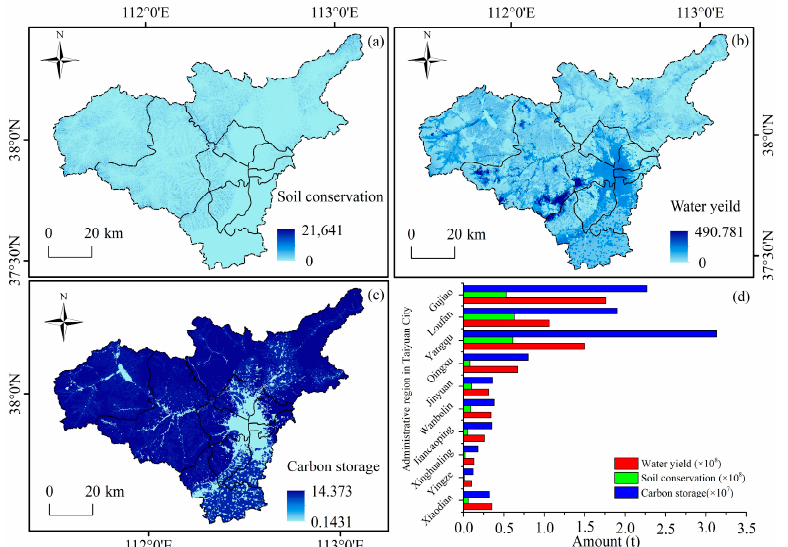
Figure 4. Distribution of ( a ) soil conservation, ( b ) water yield, and ( c ) carbon storage amount in Taiyuan City; ( d ) amount of soil conservation, water yield, and carbon storage in each administra- tive region.